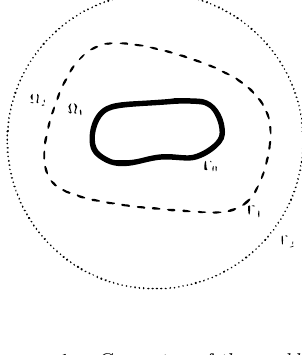
Figure 1. Geometry of the